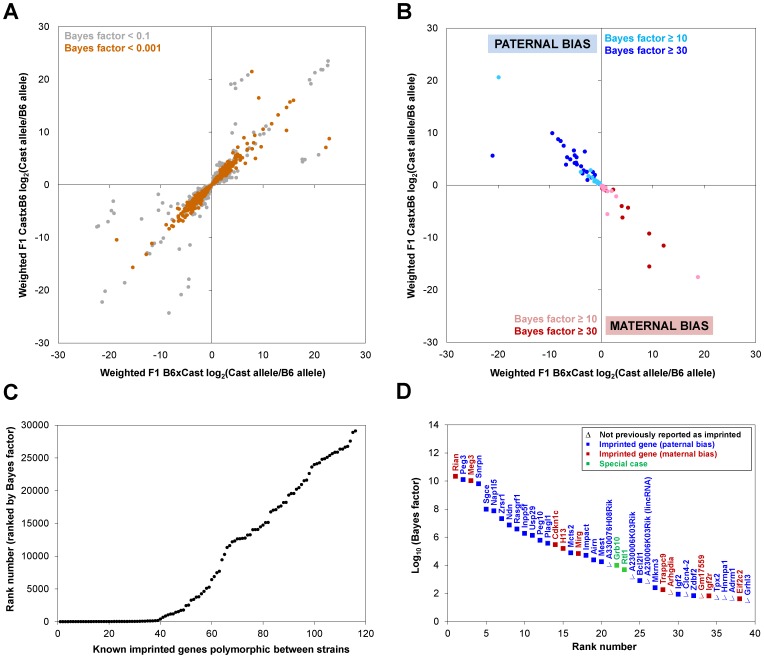
Characterization of parent-of-origin effects in the retina.Autosomal genes polymorphic between C57BL/6J and Cast/EiJ were analyzed in retinas from reciprocal F1 hybrids. Higher Bayes factors indicate greater likelihood of imprinting. (A) Non-imprinted genes with Bayes factor <0.1 (gray) and <0.001 (orange) are depicted. (B) Parent-of-origin effects with preferential expression of the paternal (blue) or maternal (red) allele with Bayes factor ≥10 (light) and ≥30 (dark) are depicted. (C) Top-ranked (low rank number) genes are enriched for known imprinted genes. (D) Genes with strong evidence of imprinting in the retina (Bayes factor ≥30) that exhibit preferential expression of the paternal (blue) or maternal (red) allele are depicted. Green, special cases—see text for discussion of Rtl1 and Grb10. Filled squares, genes previously reported as imprinted in other tissues. Empty triangles, not previously reported as imprinted. A230006K03Rik appears twice because it is associated with two Ensembl ID's, a protein-coding gene and a lincRNA.